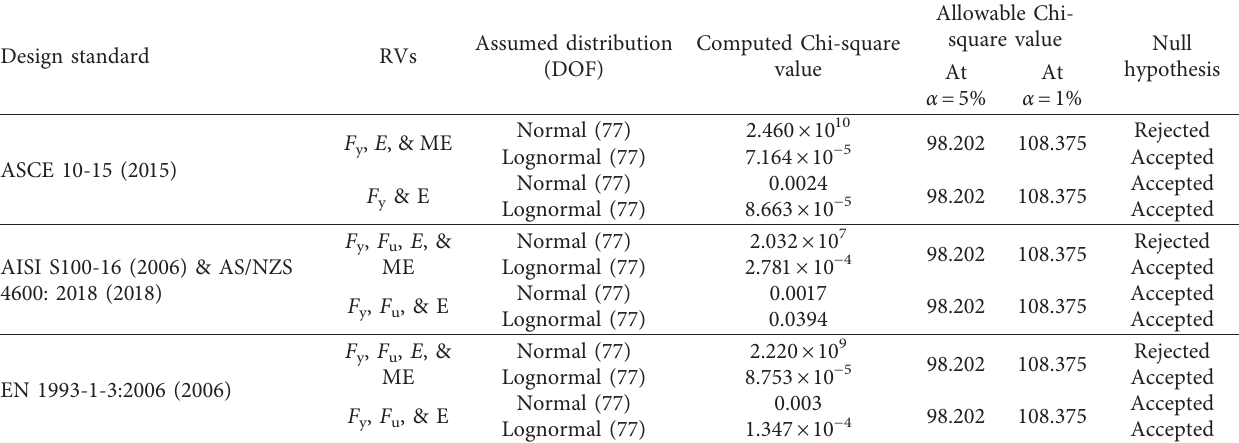
Table 8: Results of Chi-square goodness-of-fit test for resistance simulation (database column no. 18—flexure-torsion mode of buckling). Design